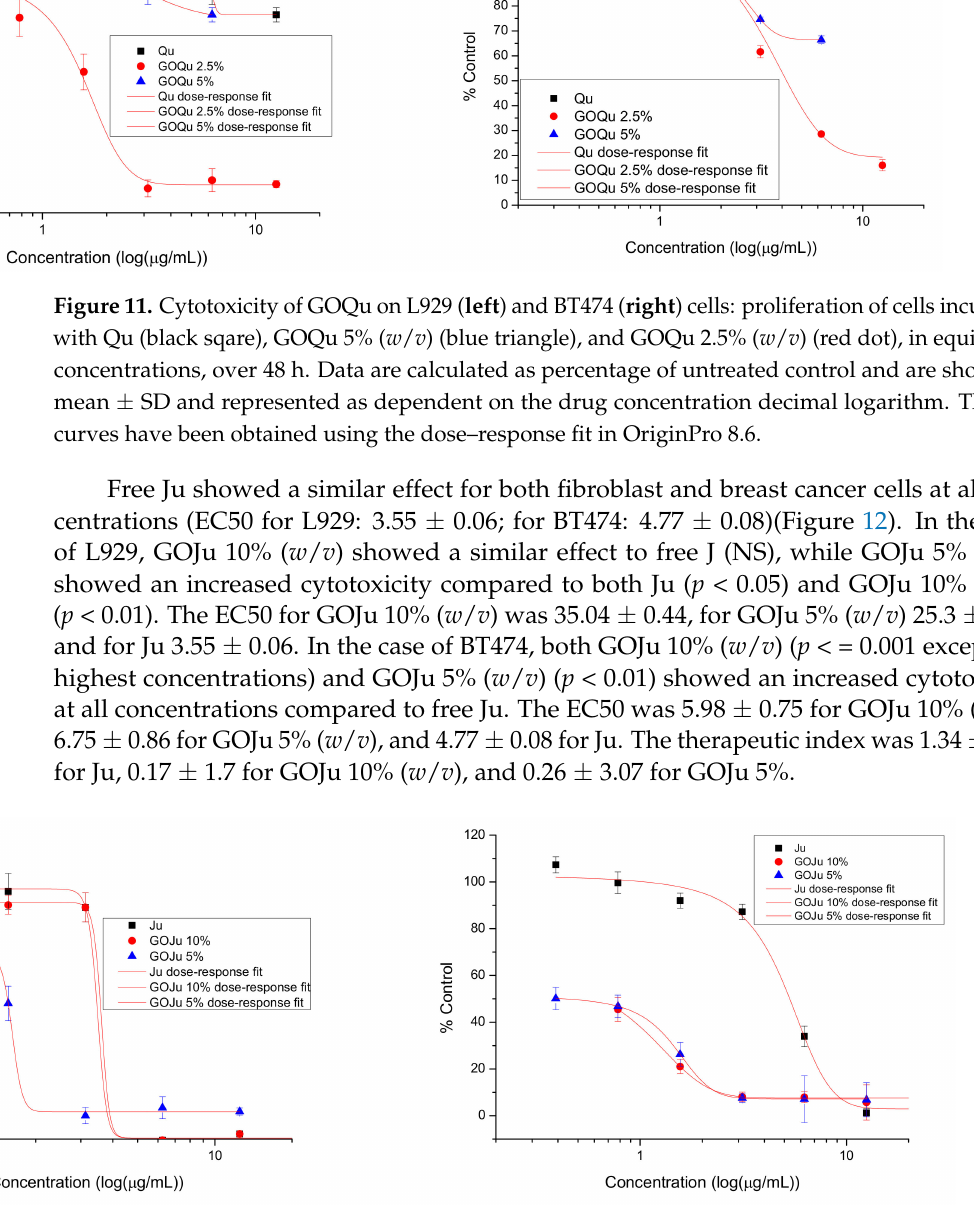
Figure 12. Cytotoxicity of GOJu on L929 ( left ) and BT474 ( right ) cells: proliferation of cells incubated with Ju (black square), GOJu 10% ( w / v ) (red dot), and GOJu 5% ( w / v ) (blue triangle), in equivalent concentrations, over 48 h. Data are calculated as percentage of untreated control and are shown as mean ± SD and represented as dependent on the drug concentration decimal logarithm. The red curves have been obtained using the dose–response fit in OriginPro